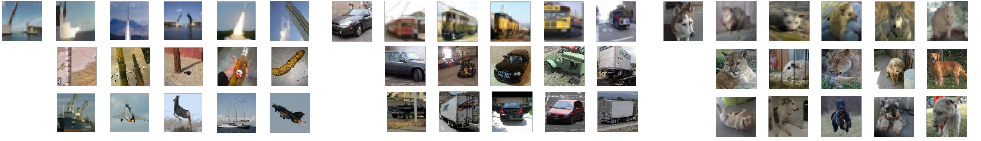
Figure 7. Qualitative results of the proposed method for Scenario 2 (three tasks). Given a query (standalone) image from each task, we drew similar images whose selected model structures were almost similar to that of the query image. Similar images from the top to bottom rows were from Tasks 1–3, respectively. Best viewed in color ( × 2).